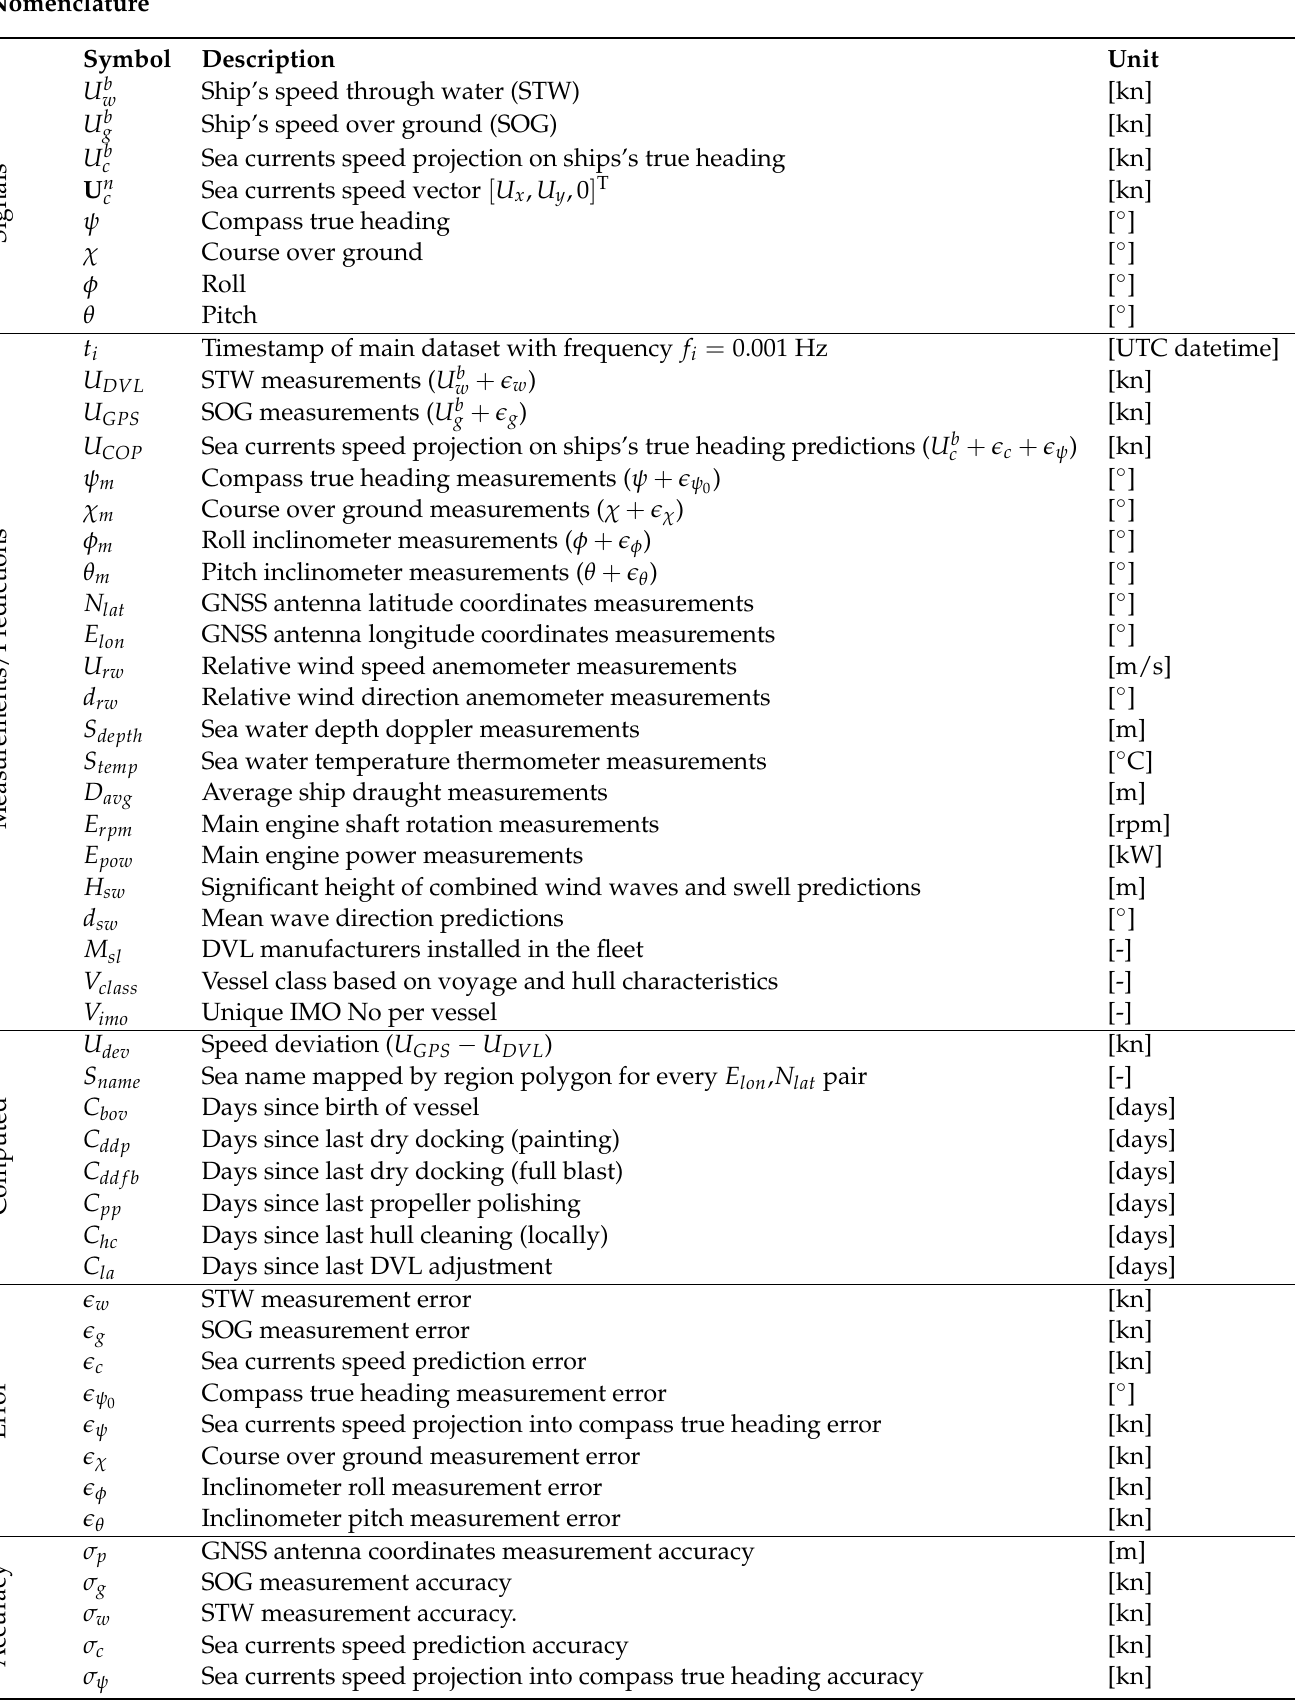
Sea currents speed projection into compass true heading